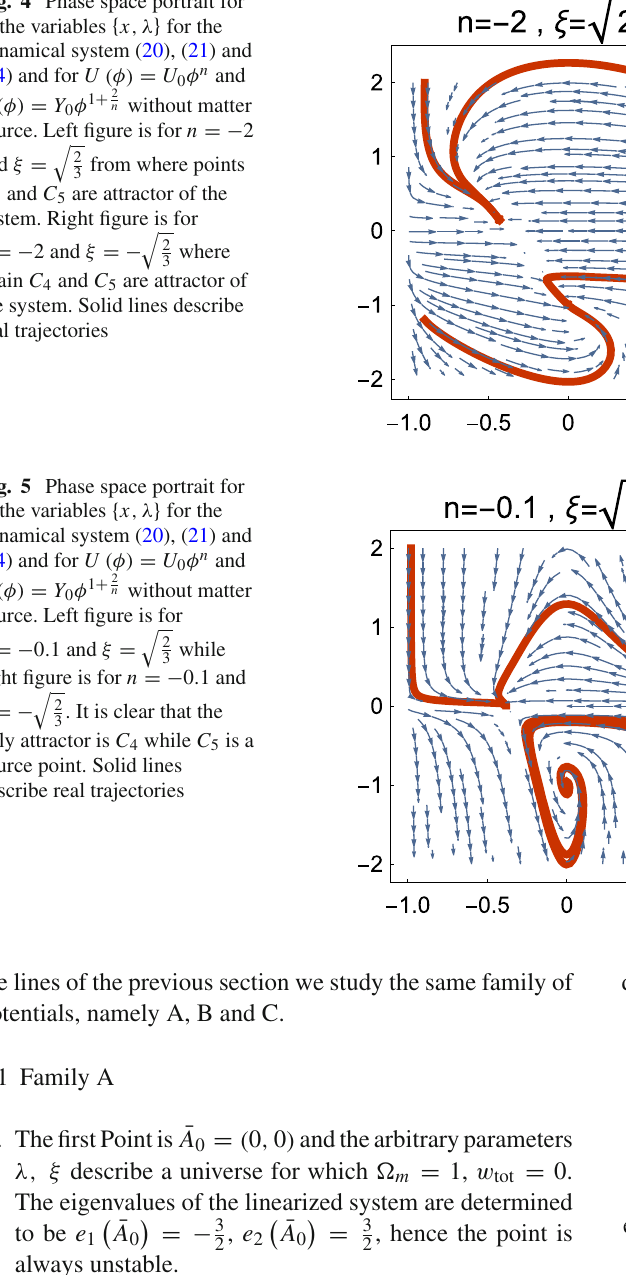
Fig. 4 Phase space portrait for in the variables { x ,λ } for the dynamical system (20), (21) and (24) and for U (φ) = U 0 φ n and Y (φ) = Y 0 φ 1 + 2 n without matter source. Left figure is for n = − 2 (cid:12) 2 and ξ = C 4 and C 5 are attractor of the system. Right figure is for (cid:12) 2 n = − 2 and ξ = − the system. Solid lines describe real trajectories